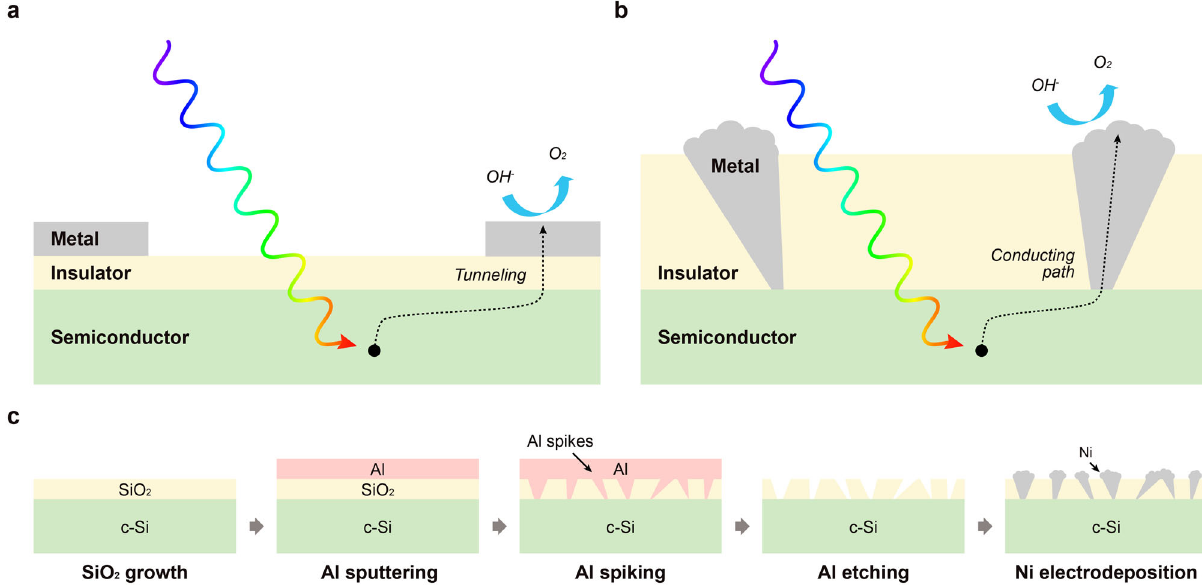
Fig. 1 Schematics of metal-insulator-semiconductor photoanodes. a Schematic illustration of conventional approach for photogenerated carrier transport, via tunneling, across thin electrically insulating layer in MIS photoelectrode. b Schematic illustration of localized metallic conduction paths through a thick electrically insulating layer, enabling the use of much thick insulators that provide high stability in an MIS photoelectrode. c Schematic illustration of a highly scalable, nonlithographic fabrication process for realizing structure shown in b